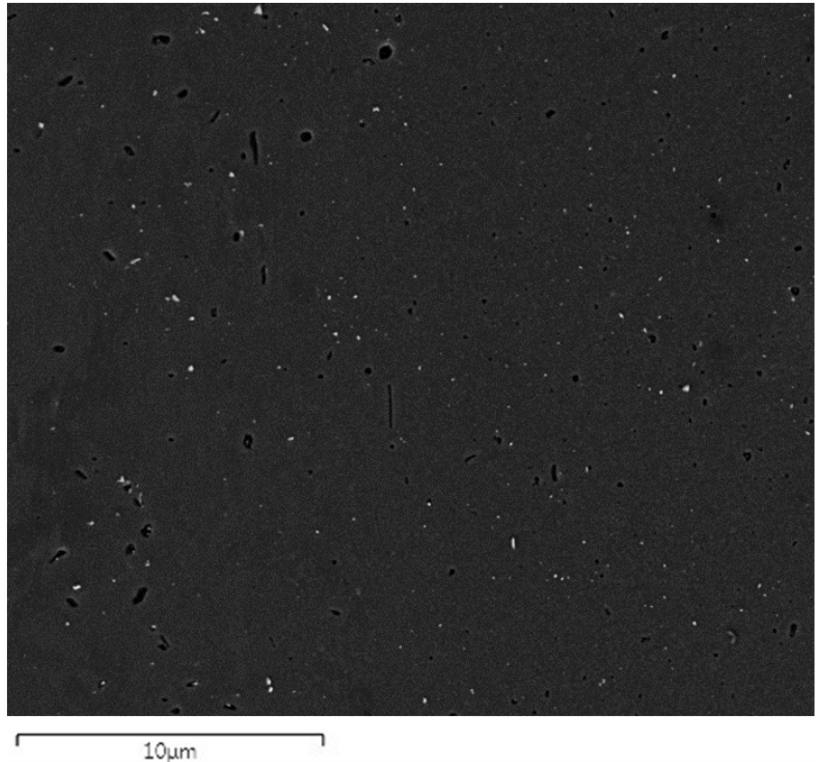
Figure 5. SEM micrograph taken in BSE mode from the dynamically recrystallized zone (DXZ) in Figure 4, showing refined intermetallic particles (small bright particles).